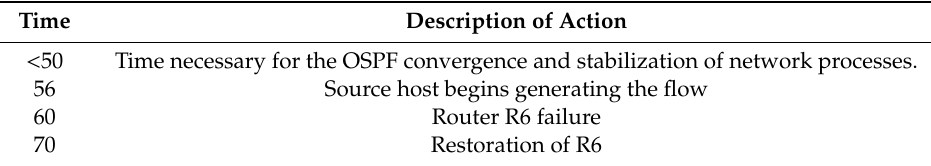
Table 4. Description of the simulation scenario.